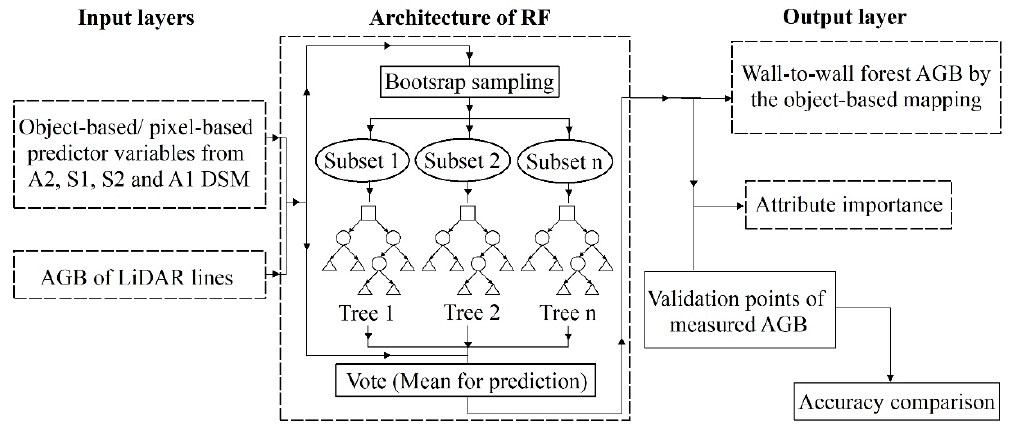
Figure 5. Delineation of random forests (RF) mapping of forest AGB based on LiDAR lines and multi-sensor images.